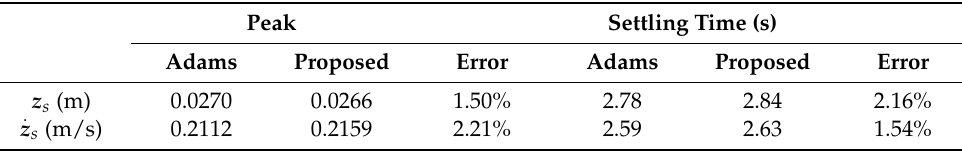
Figure 12. Dynamic responses of vehicle body for a single bump: ( a ) ver-tical displacement; ( b ) verti- cal velocity. Table 4. Characteristic values of the dynamic responses of the vehicle